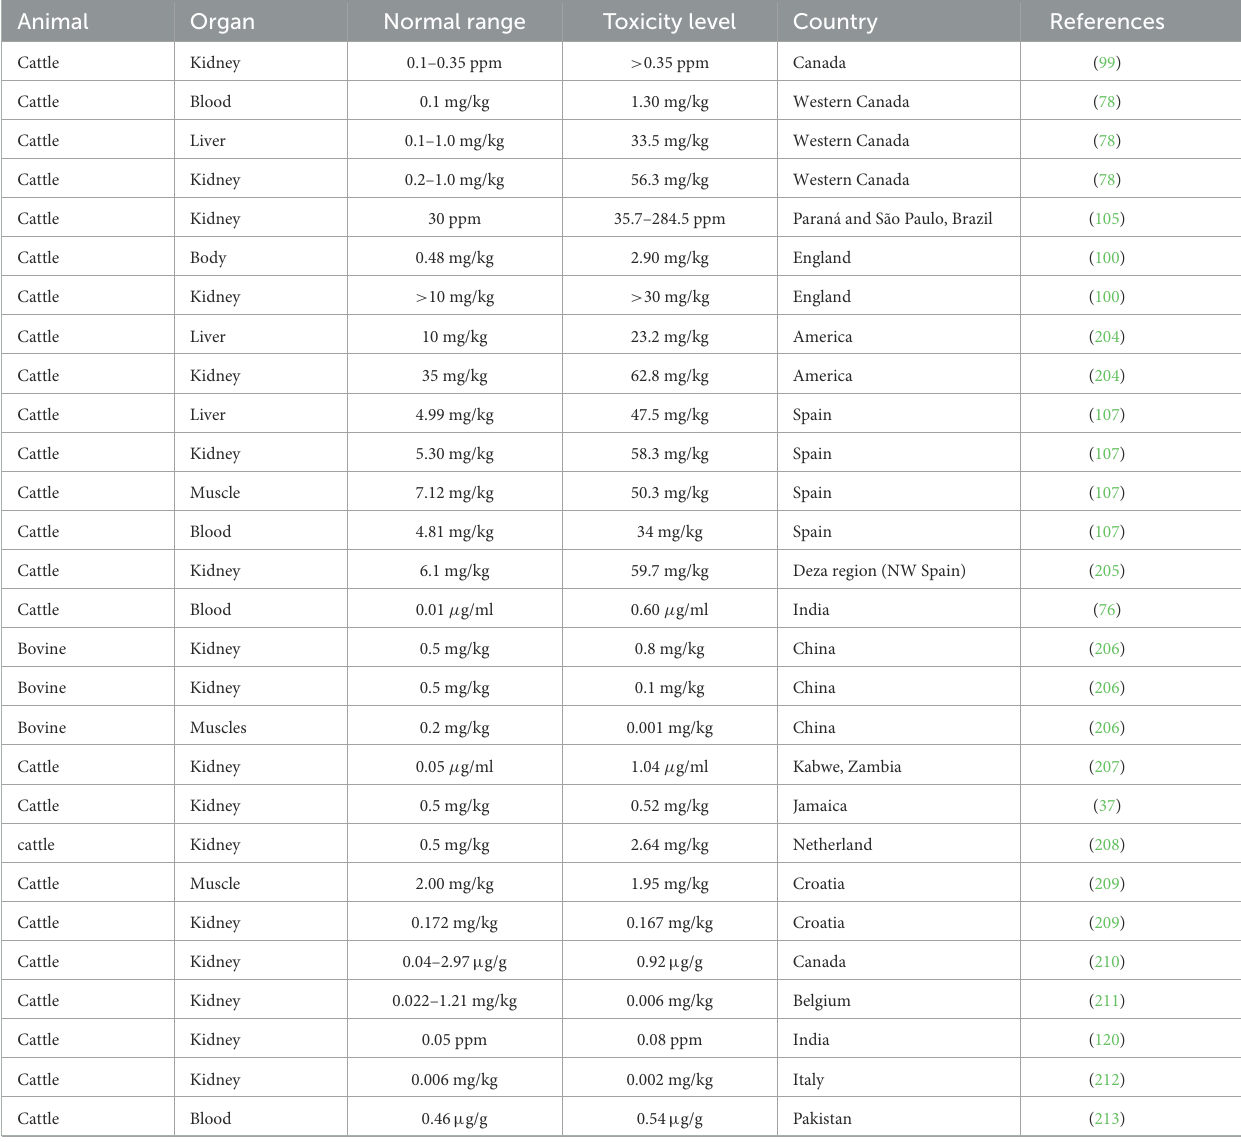
TABLE 1 Lead toxicity observed in different organs of cattle.